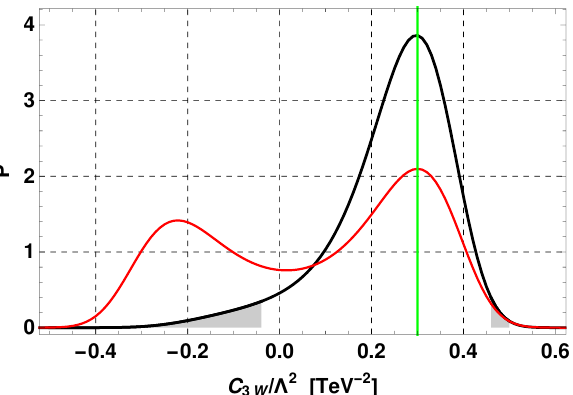
Figure 6 . Posterior probability for the inclusive and exclusive analysis after 3 ab (cid:0) 1 at LHC, see details in the main